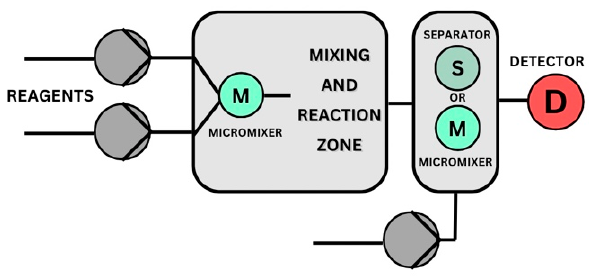
Figure 9. Schematic figure of microfluidic system components.